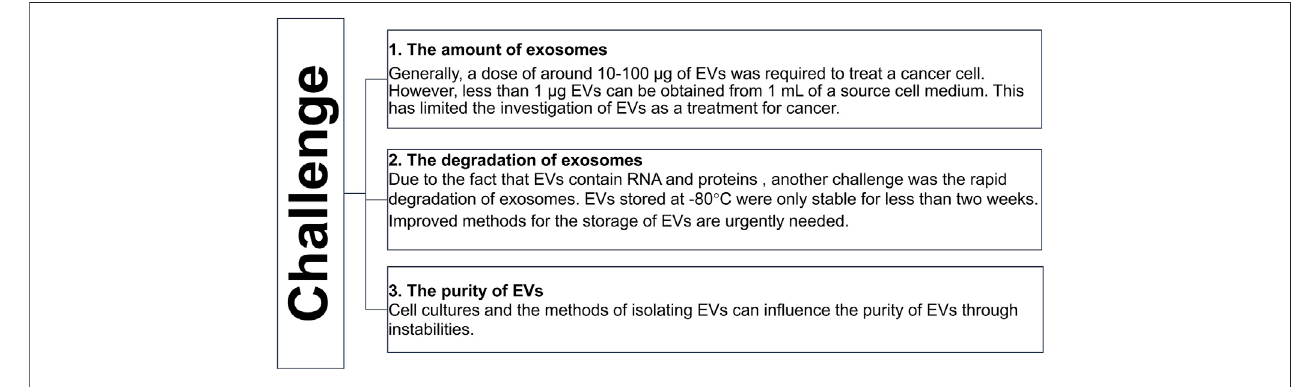
FIGURE 5 | The challenge of